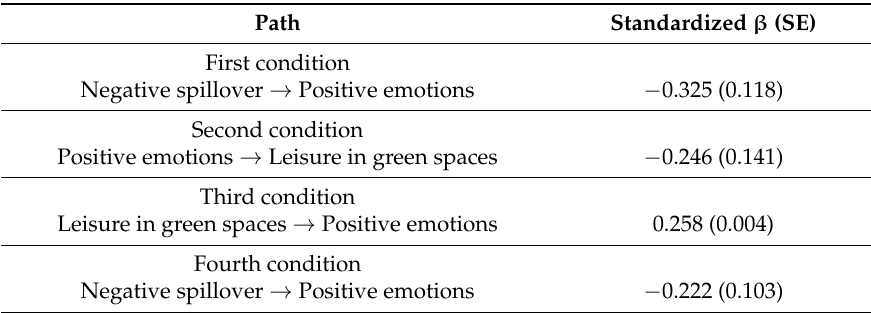
Table 3. Modified Path Model and Test of the Mediating Effect.